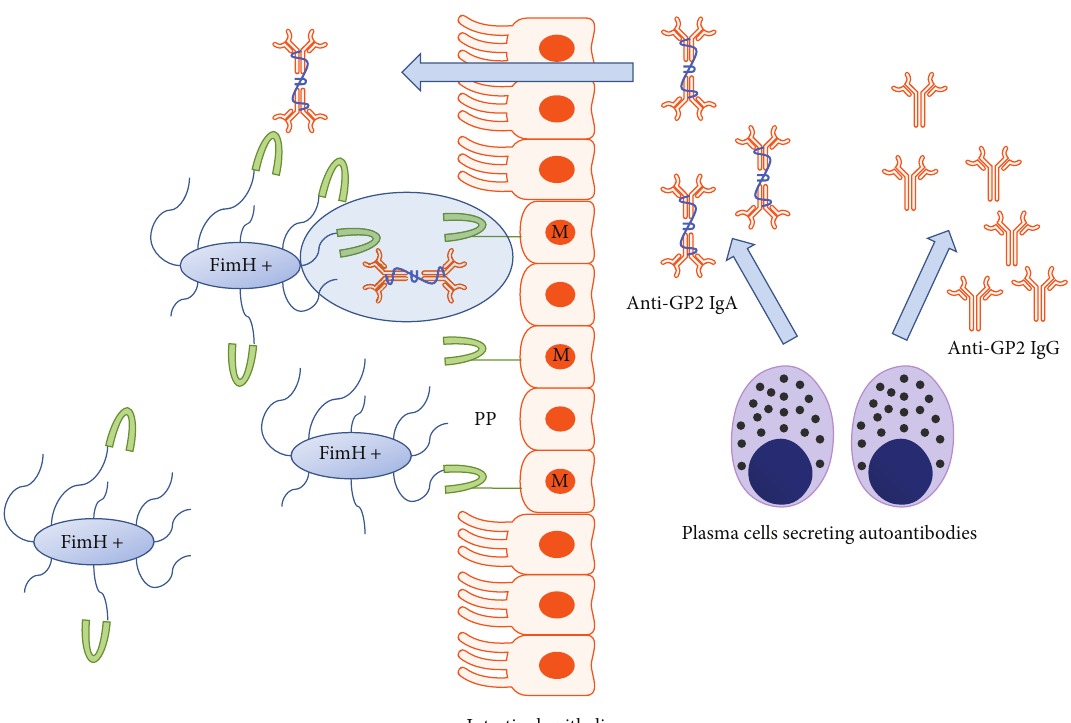
Figure 2: Glycoprotein 2 ((GP2) green) is synthesized by acinar pancreatic cells and released together with digestive enzymes into the intestinallumen.ProvidedthatGP2isnotdigestedbyactivatedenzymes,GP2canopsoniseFimHpositivemicrobes(FimH+)intheintestine. Additionally, GP2 has been demonstrated on the surface of microfold cells (M cells) of the Peyer’s patches (PP) of the follicle-associated epithelium. This form of GP2 can interact with FimH positive bacteria and partake in the transcytosis thereof by the M cells. After the loss of tolerance towards GP2, plasma cells can synthesize anti-GP2 IgA which will be actively transported by the epithelium into the lumen of the intestine. The secreted anti-GP2 IgA can bridge FimH positive bacteria opsonised by pancreatic GP2 with the membrane-bound GP2 on the M cells (highlighted). Ultimately, this could lead to an overload of microbes in the mucosa due to an elevated transcytosis rate accelerating intestinal inflammation